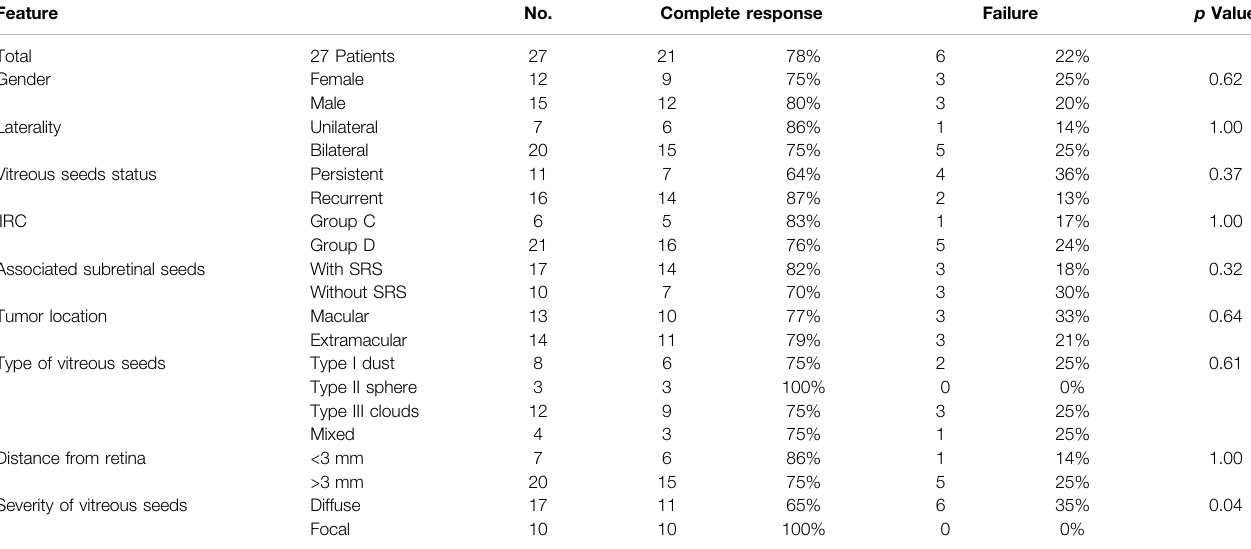
TABLE 1 | Demographics, tumor characteristics, and management outcome. Feature